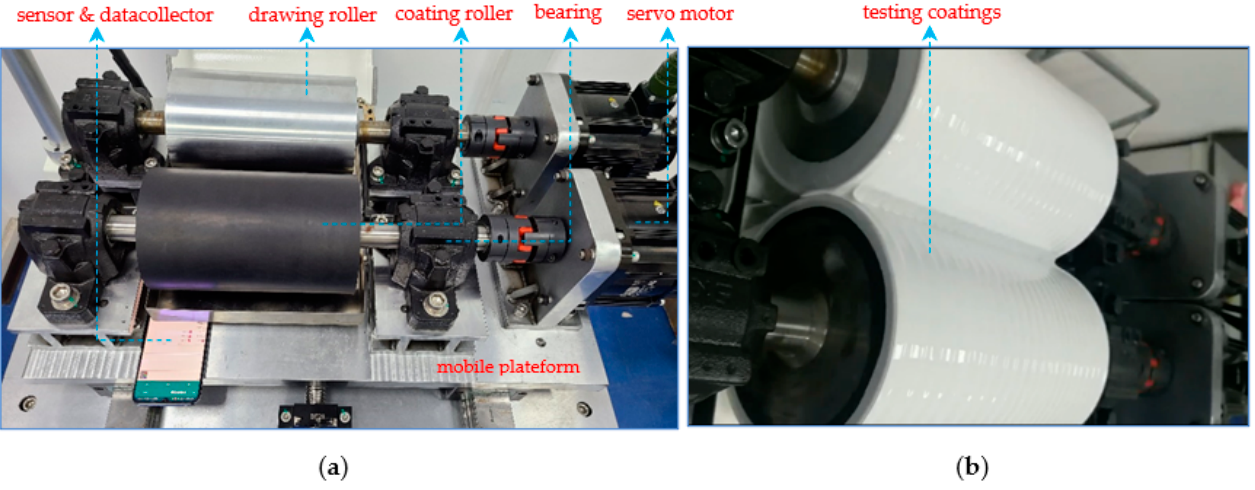
Figure 11. ( a ) Construction of vibration experiment platform; ( b ) The roller-coating operation effect test.